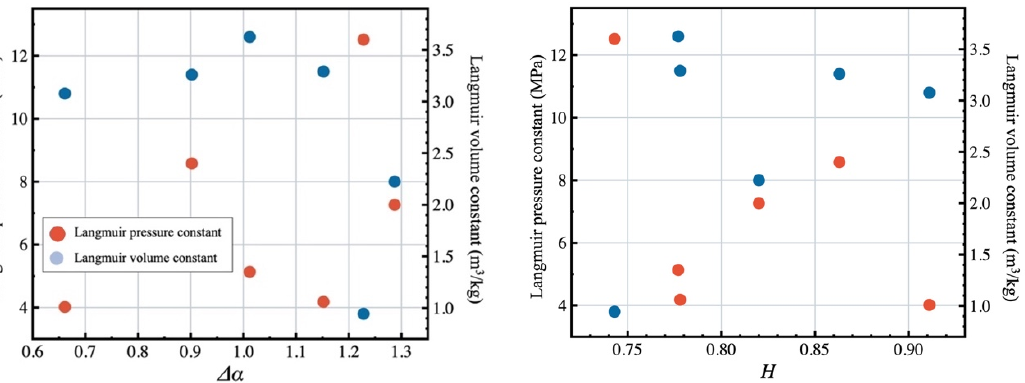
Figure 10. The relationships between multifractal characteristic parameters of organic pores and Langmuir parameters.